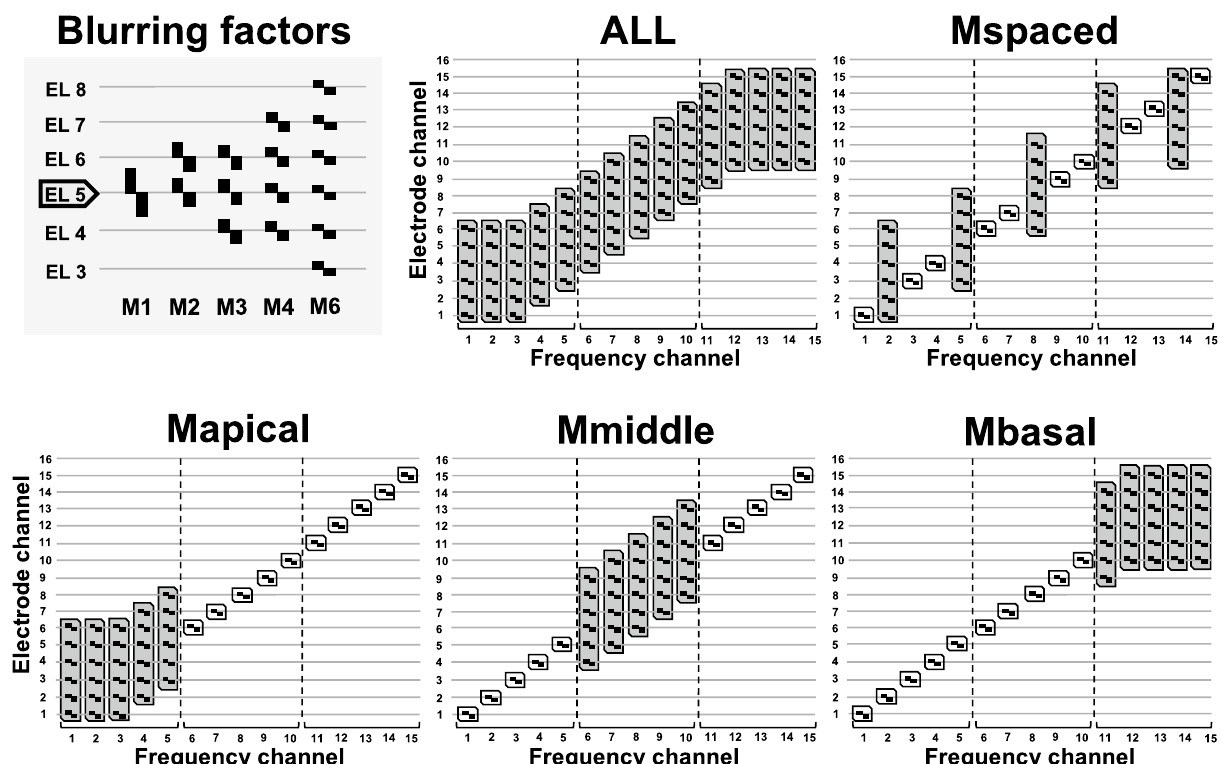
Figure 2. Illustration of the electrode stimulation pattern used for spectral blurring. The top left part shows the blurring factors of 1 to 6 simultaneous electrodes used in the experimental maps (centred at electrode 5 in this example). The ALL plot shows a condition using 6 simultaneous stimulation electrodes for each of the 15 active frequency channels. The 5-of-15 conditions (Mspaced, Mapical, Mmiddle and Mbasal) use clusters of 5 adjacent or 5 evenly-spaced electrodes with a blurring factor of 6